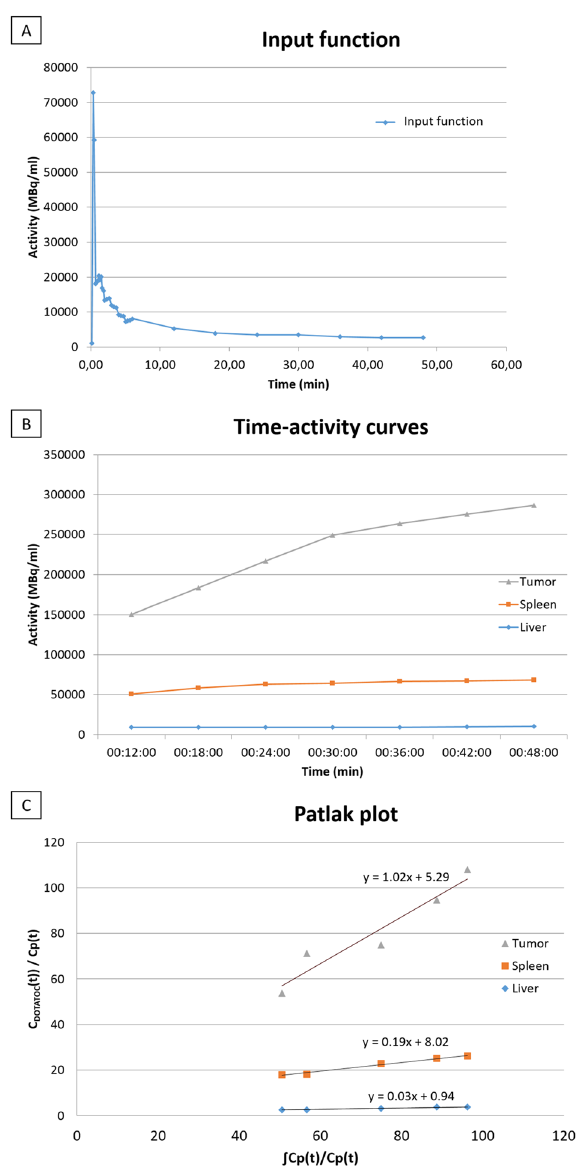
Figure 2. Example of dynamic acquisition data processing in a patient with a highly DOTATOC-avid pancreatic tumor (SUVmax = 159.54 SUVmean 98.29 and Ki = 102.41 ml/min/100 ml) (Top: Input function; Middle: Time-activity curve; Bottom: Patlak